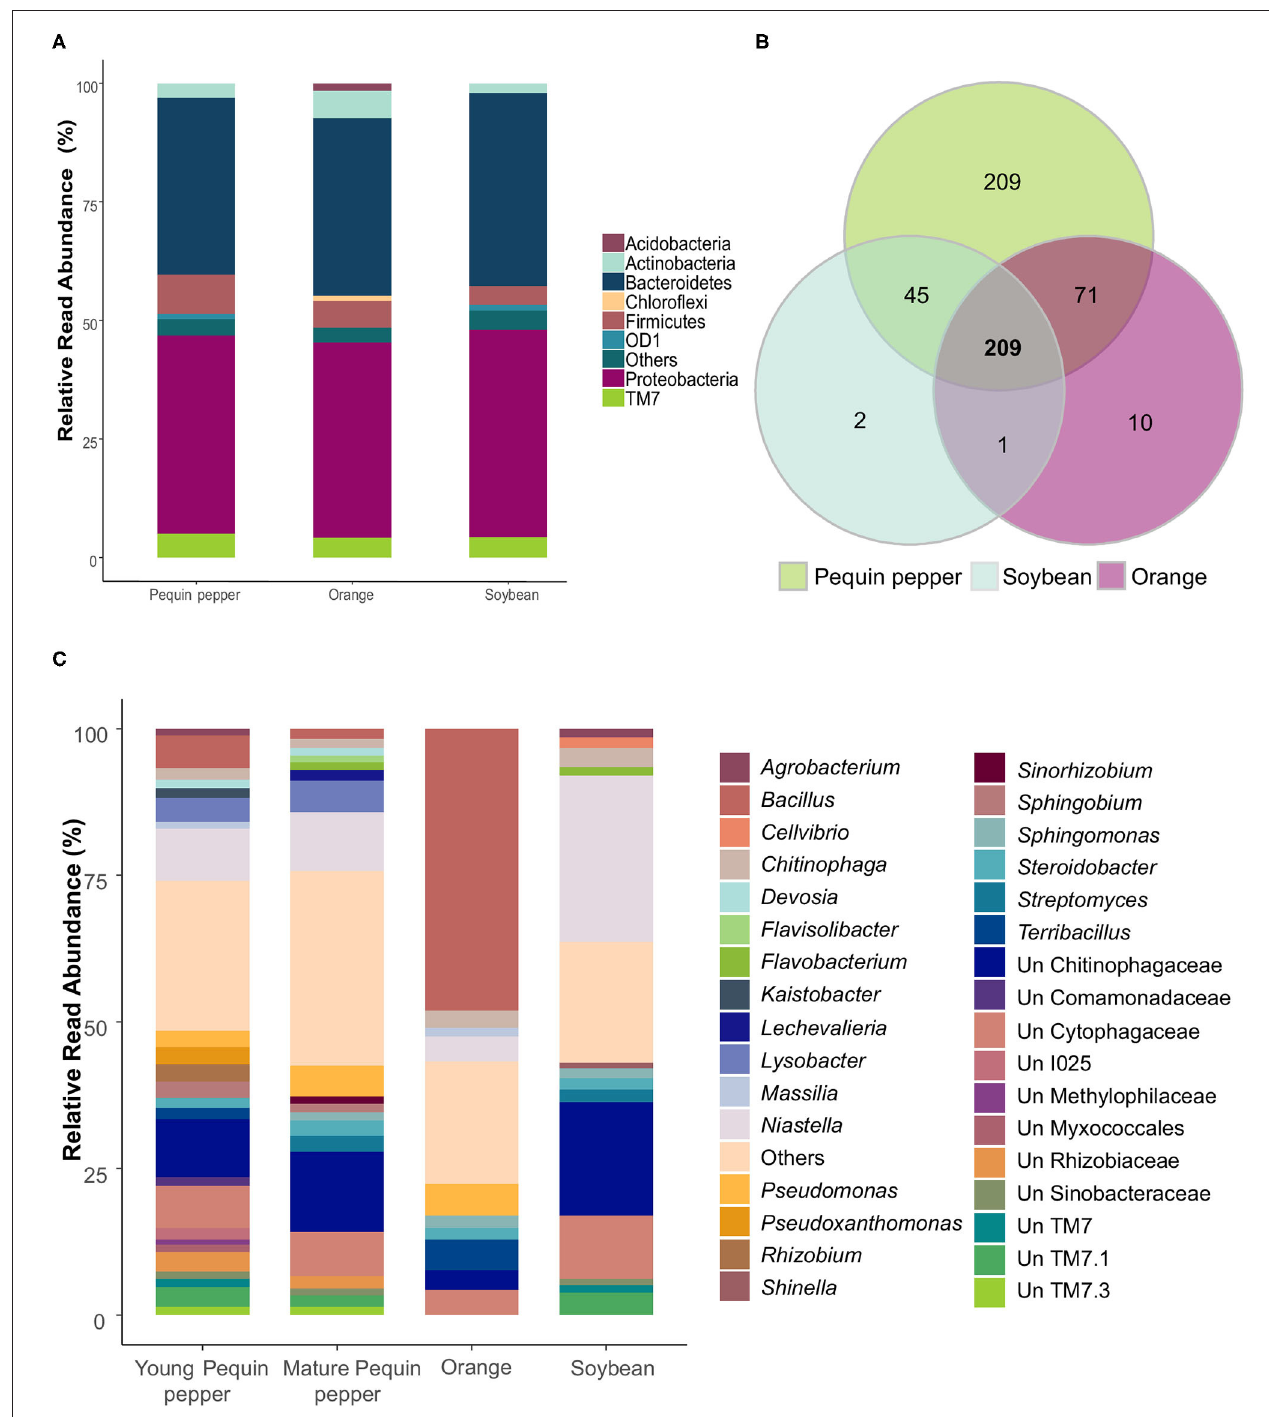
FIGURE 2 | Bacterial community composition of Pequin pepper, soybean and orange tree. (A) Relative read abundance of phyla for each crop. (B) Venn diagram of genera shared among crops. (C) Relative read abundance of genera present in Pequin pepper (young and mature shown separately), orange and soybean. “Un” stands for unclassified to the genus level. Genera represented by < 1% were grouped as “Others”.